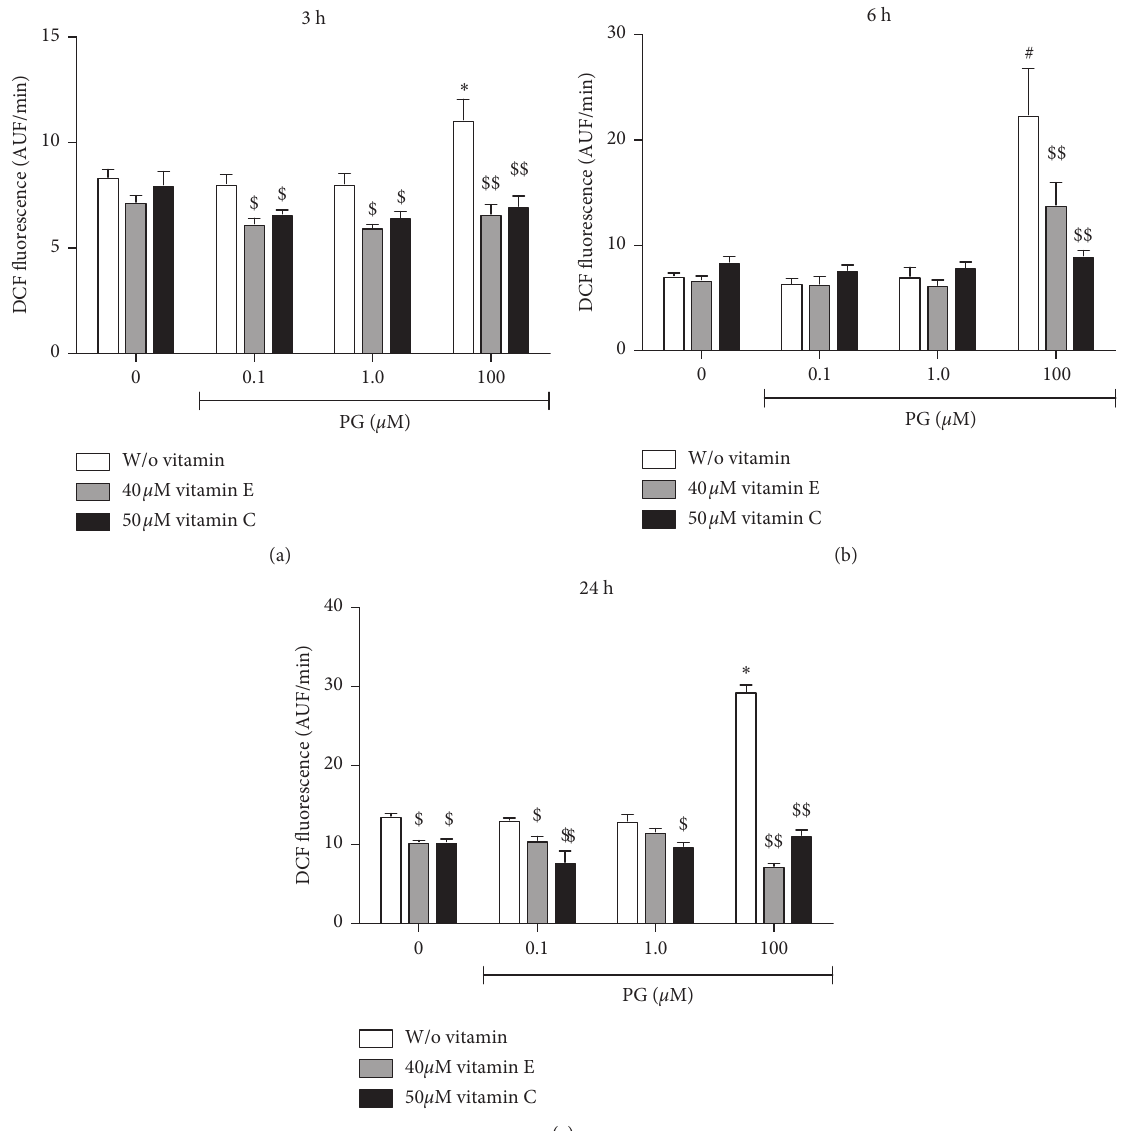
Figure 9: ROS content measurement in progesterone-treated RINm5F cells. Cells were preincubated with 40 μ M vitamin E or 50 μ M vitamin C for 2h, and then with 0.1, 1.0, or 100 μ M progesterone for 3 (a), 6 (b), or 24h (c). ROS content was measured by DCFDA probe (10 μ M) during 60min. Data are expressed as mean ± SEM of DCF formation (AUF/min) of three experiments in quadruplicates, after normalization to the number of viable cells in each sample. ∗ indicates difference in comparison to control without progesterone. $ and $$ indicate difference in comparison to the treatment without antioxidants ( ρ < 0.05 and ρ < 0.001, respectively). PG: progesterone; Vit E: vitamin E; Vit C: vitamin